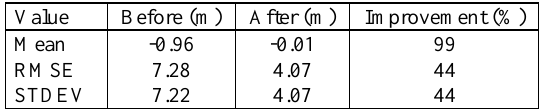
Table 1. Height difference values for area #1 before and after morphing, with no triangle threshold.